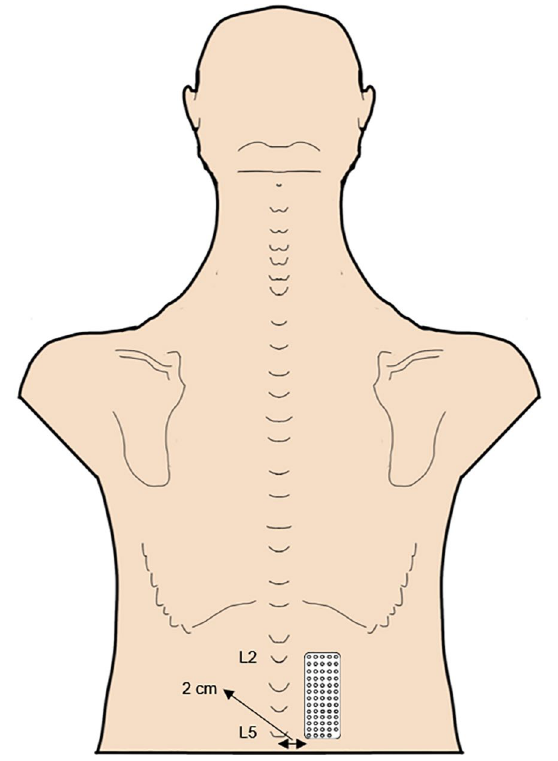
Figure 1. Representation of the position of the HDsEMG electrode grid that was placed over participants’ lumbar